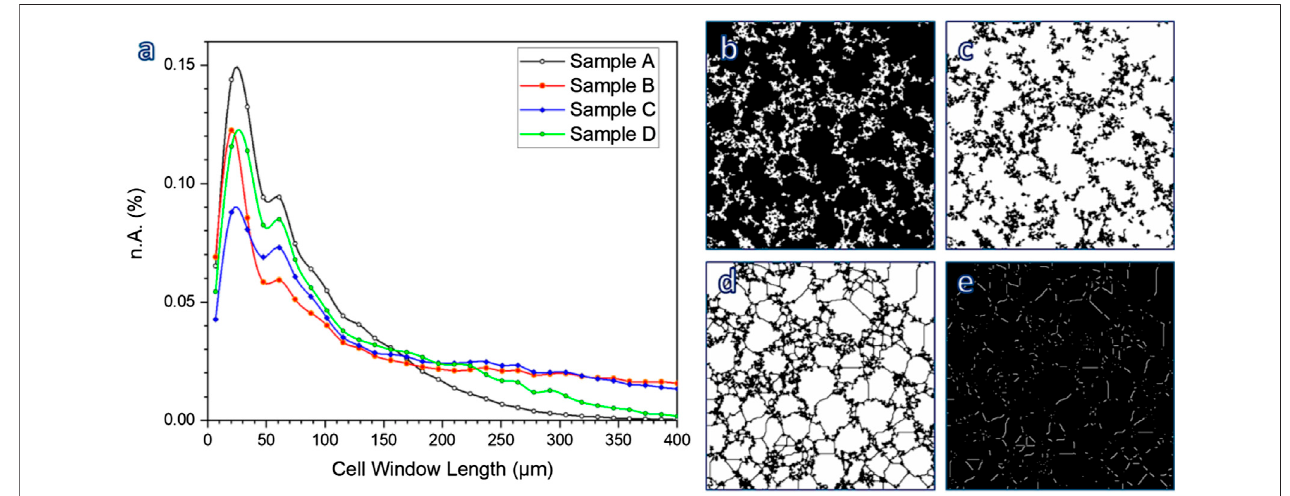
FIGURE 10 | (A) Determination of cell window length; (B – E) examples of image treatment for